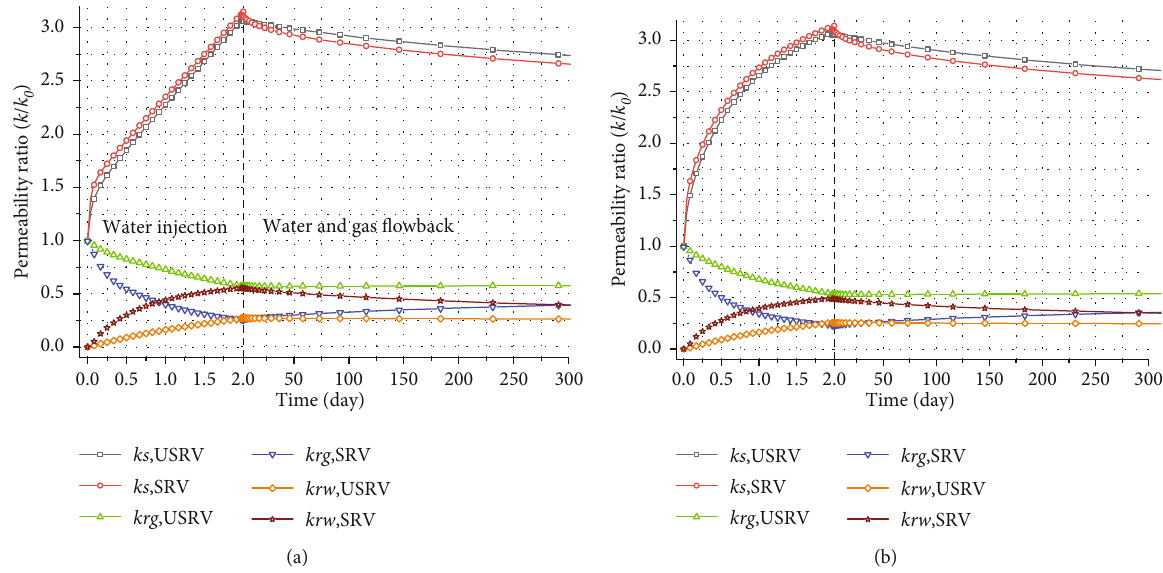
Figure 14: Gas/water relative permeability: (a) scenario B and (b) scenario